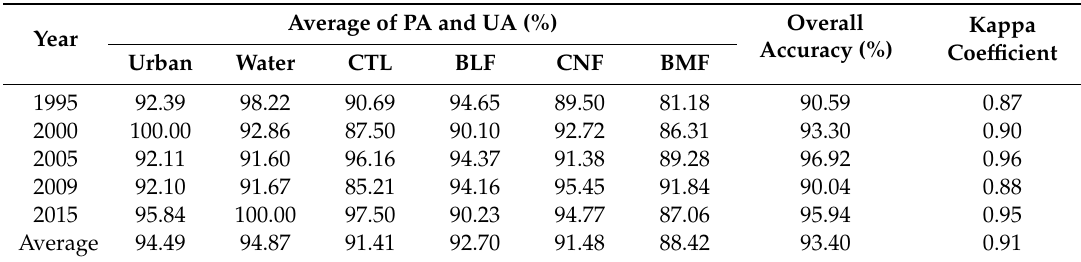
Table 4. Classification accuracy of land use types in di ff erent years.